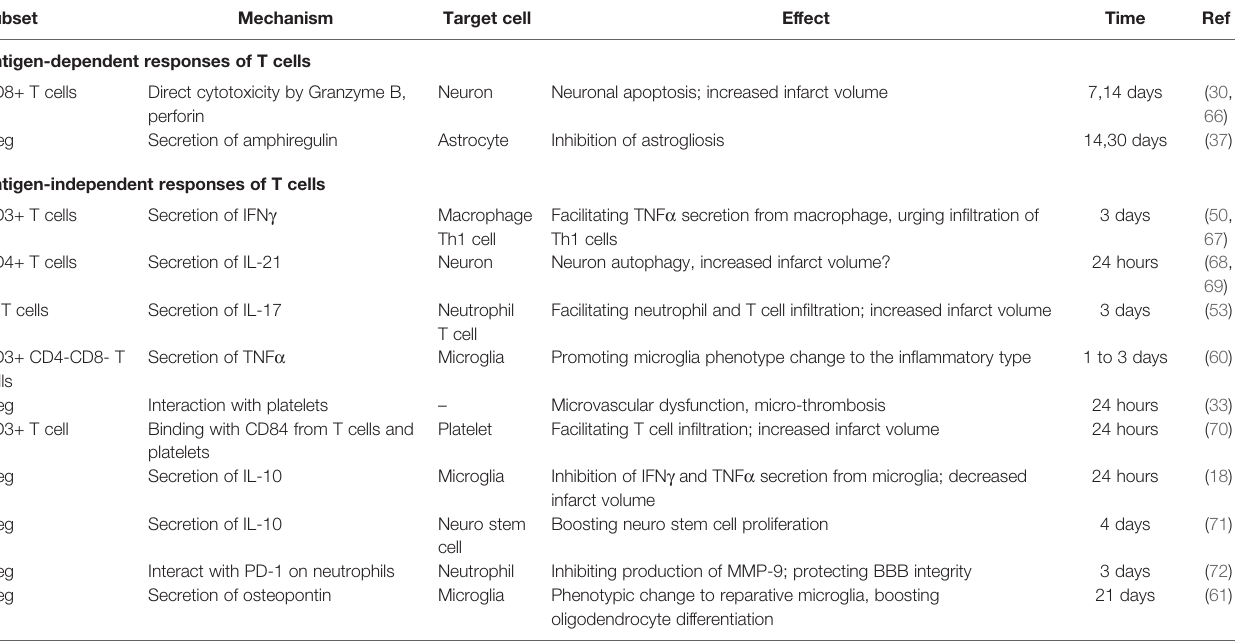
TABLE 3 | Antigen-dependent and antigen-independent responses of T cells in ischemic